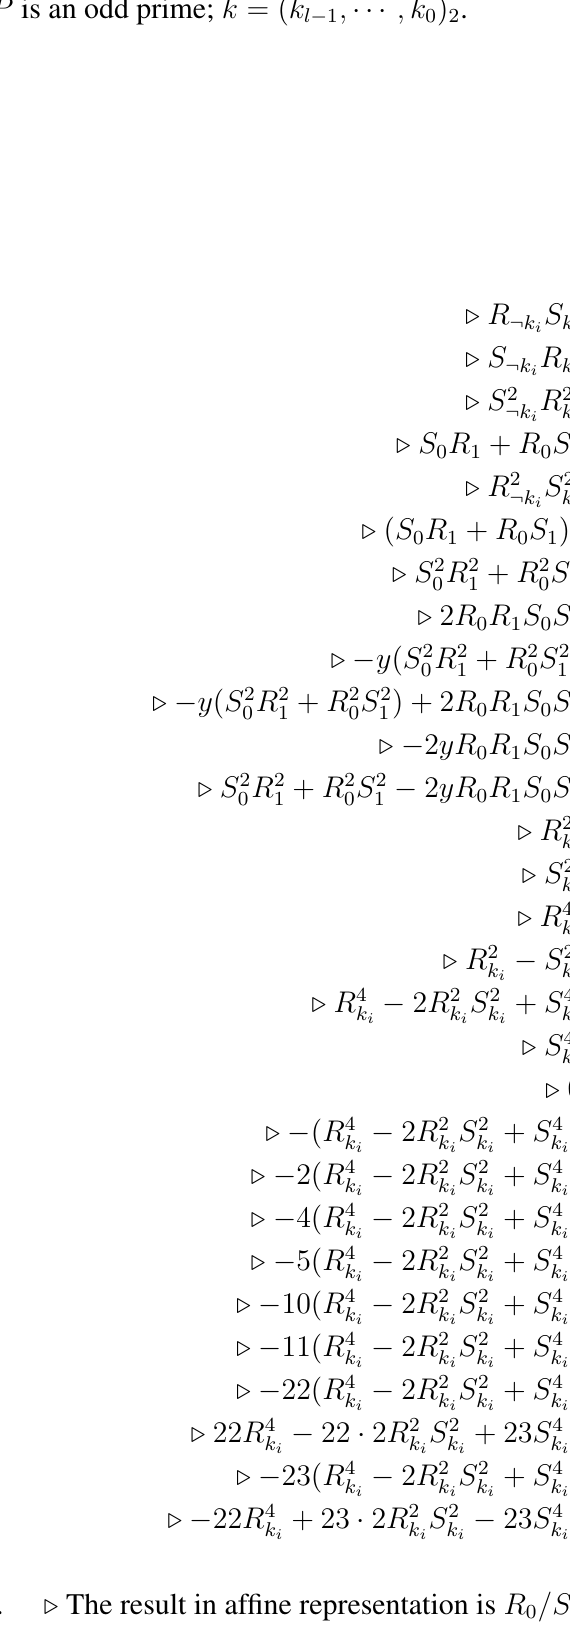
Algorithm 1 Scalar multiplication (Montgomery’s technique) [a = 92, d =